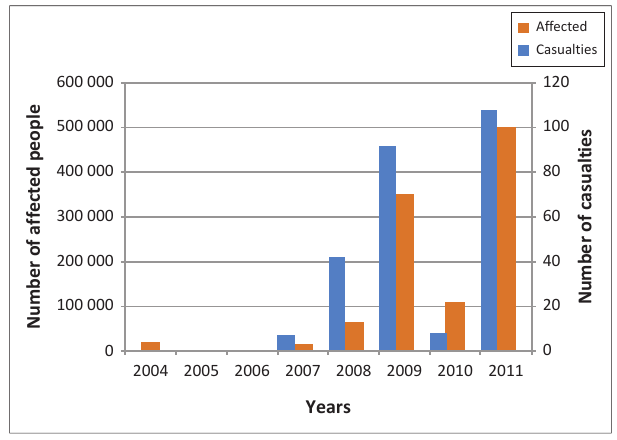
FIGURE 3: Inventory data for Namibia from 1900–2014 showing the number of people affected and the casualties caused by flooding.